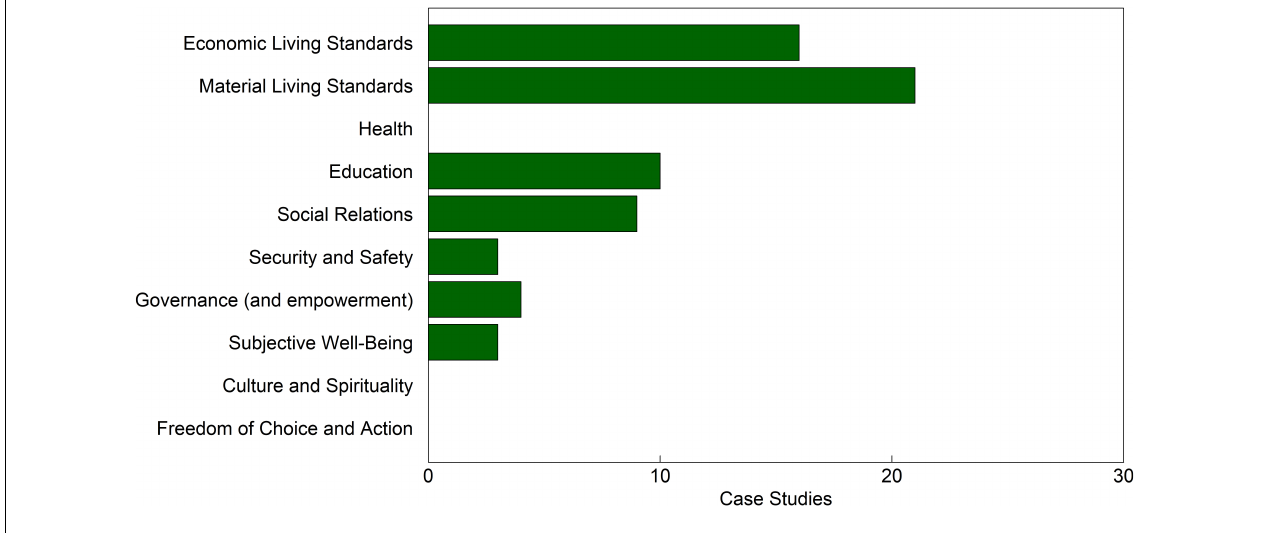
FIGURE 6 | The socioeconomic outcomes recorded in the restoration cases